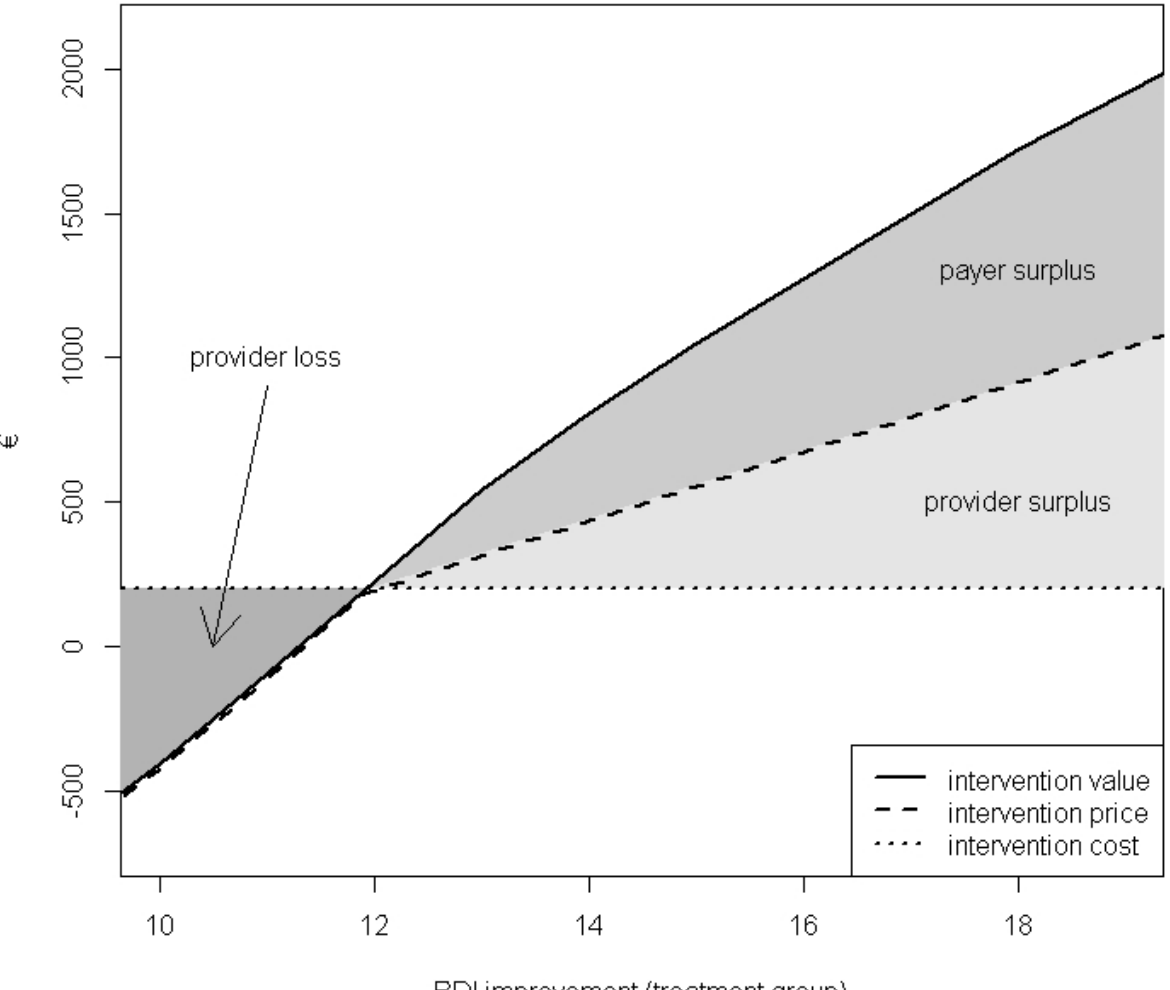
Figure 2. Relation between intervention value, price, and cost, depending on the actual efficacy (BDI improvement) during routine use (intervention value calculated using €30,000/QAL Y threshold; shaded regions depict provider loss and social surplus, shared between the provider and payer at